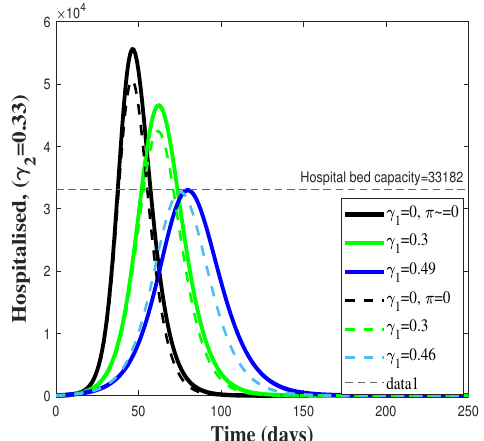
Fig. 7: Population level plots for hospitalized in- dividuals for varying values of γ 1